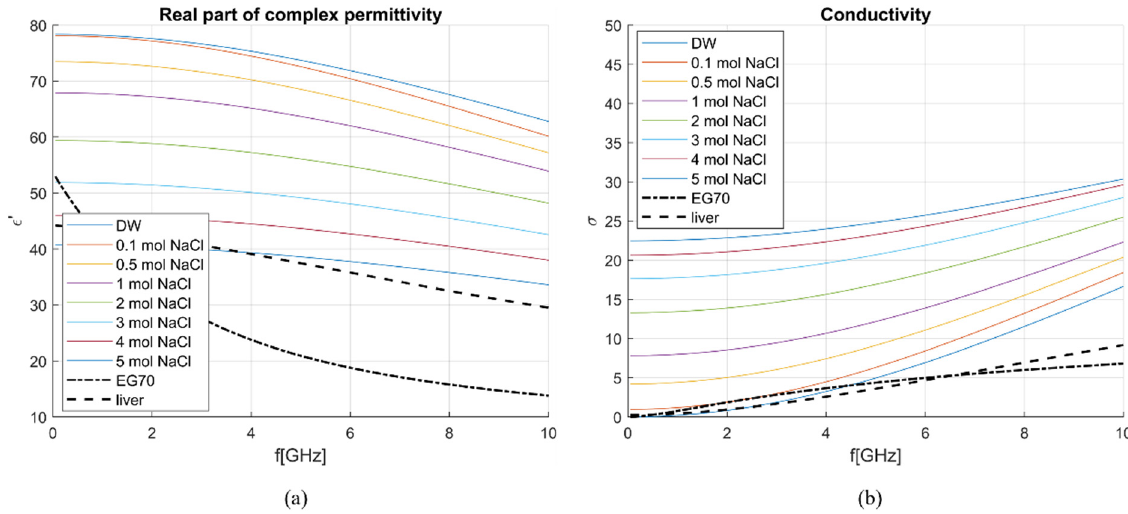
Figure 11. Dielectric properties of different NaCl solutions, EG70, and liver: ( a ) ε ’ and ( b ) σ .